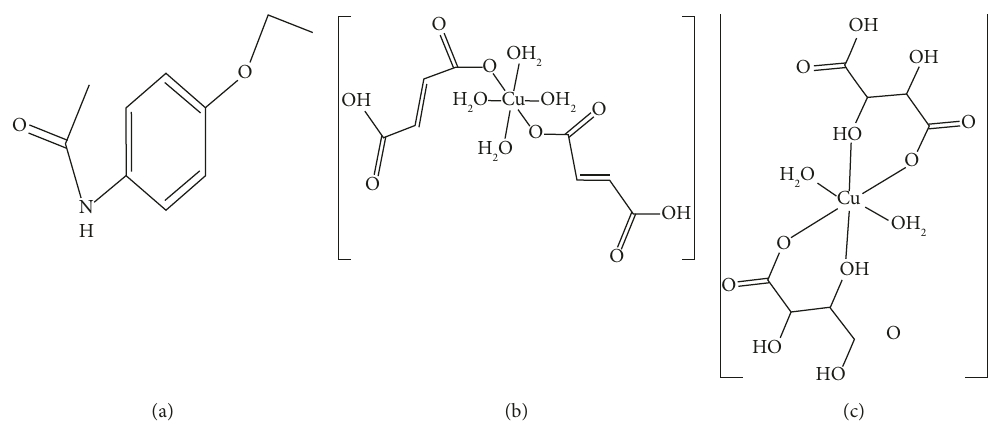
Figure 3: Structure of phenacetin (a), copper (II) fumarate (CuFum) (b) and copper (II) tartrate (CuTart) (c).